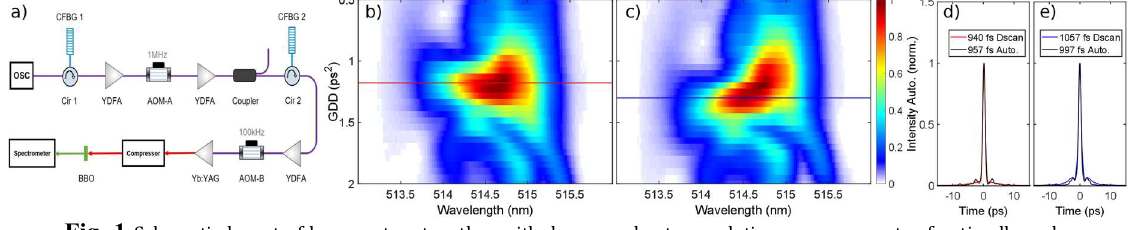
Fig. 1 Schematic layout of laser system together with d-scan and autocorrelation measurements of optimally and non-optimally compressed pulses after a grating compressor. (b) and (c) measured d-scan traces with different amount of introduced residual TODs by CFBG. (d) and (e) comparison of autocorrelation measurements (black curves) and reconstructed autocorrelations traces from d-scan measurements at optimum compression points (b) and (c), respectively. The values correspond to the width of the autocorrelation trace. The retrieved pulse durations from d- scan method are 665 fs and 747 fs for d) and e),